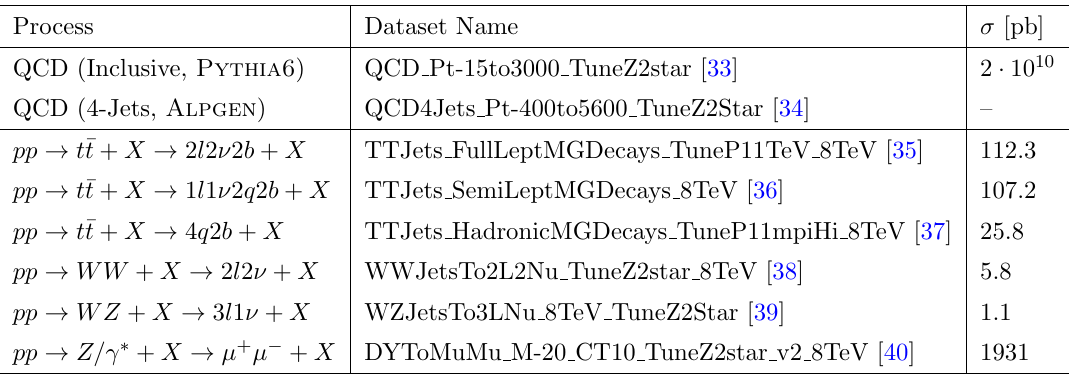
Table 2 . Overview of data samples and simulated event samples used in this analysis together with the corresponding inclusive cross-sections. Leptonic decay ( e; (cid:22); (cid:28) ) are denoted with l .